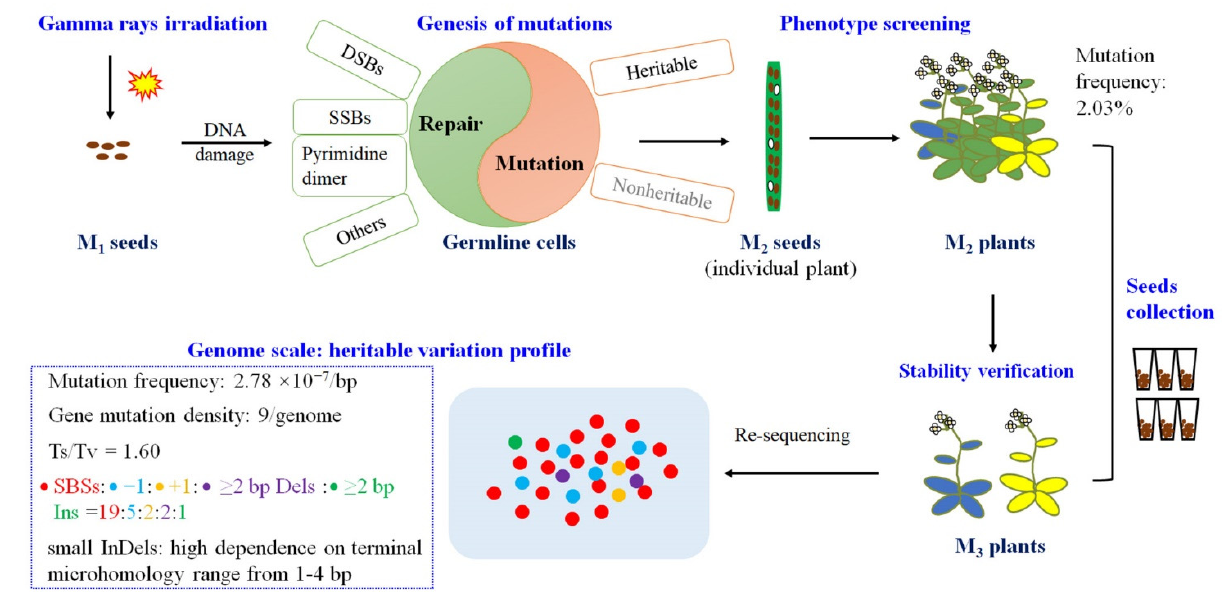
Figure 7. The mutation profile of mutations induced by gamma rays in Arabidopsis thaliana.